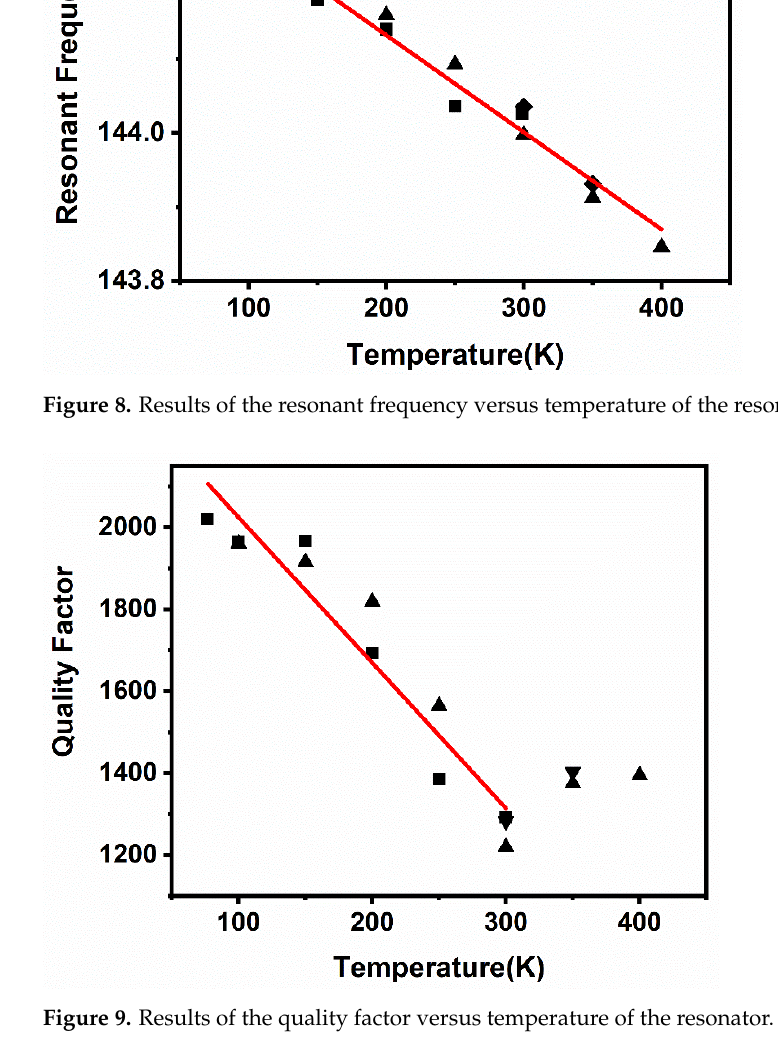
Figure 9. Results of the quality factor versus temperature of the